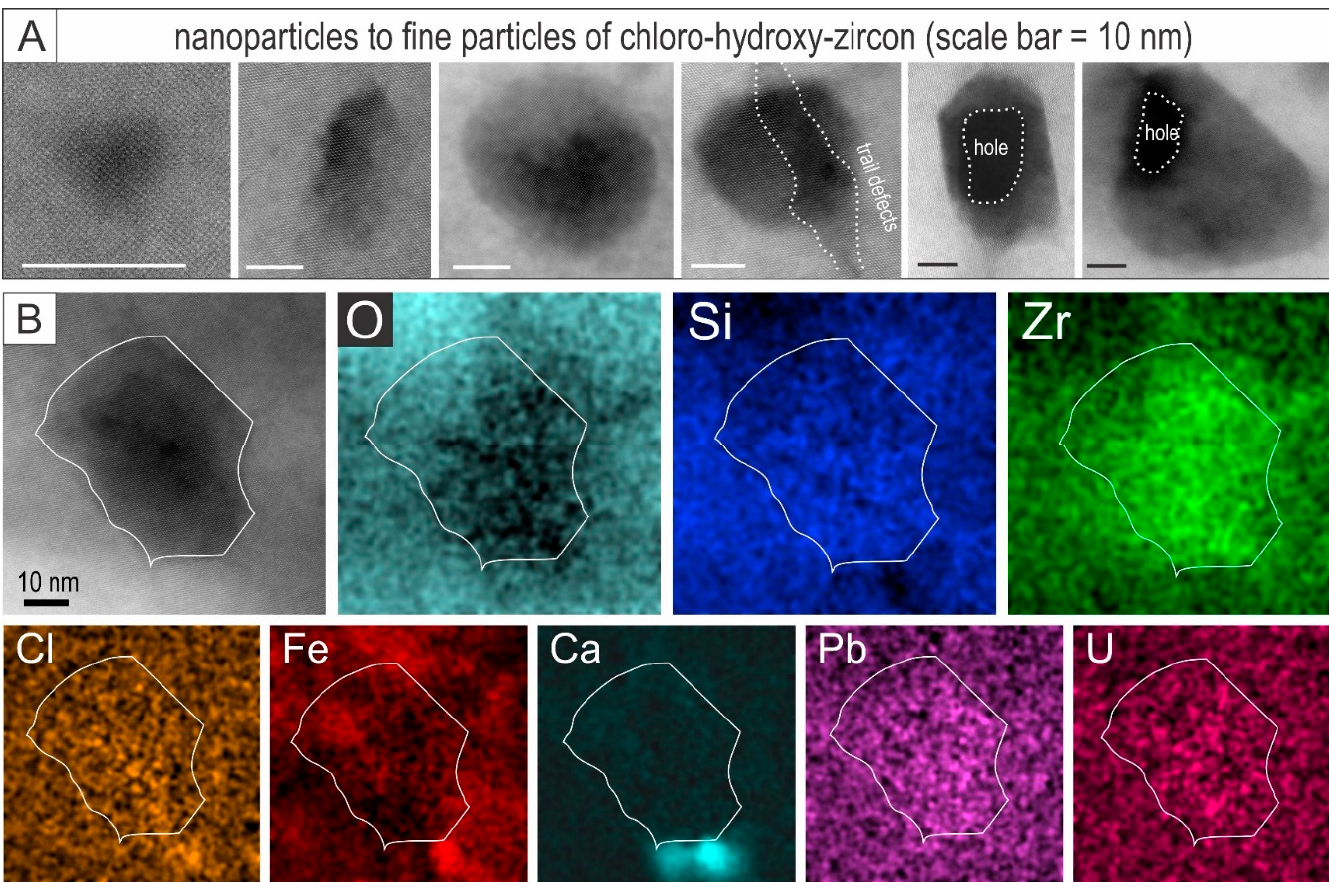
Figure 11. ( A ) HAADF STEM images of inclusions representative of all samples with mottled textures showing their variation in size and morphology as marked. Note the presence of rounded pores in the coarsest particles. ( B ) Image and EDS STEM maps of a single particle from the OD distal zircon (Foil #1). Note the strong variation in O and Zr concentration but not Si relative to host zircon and the weak relative enrichment in Cl, U, and Pb. Ca-rich nanoparticles occur just outside, at the lower edge of the mapped particle.